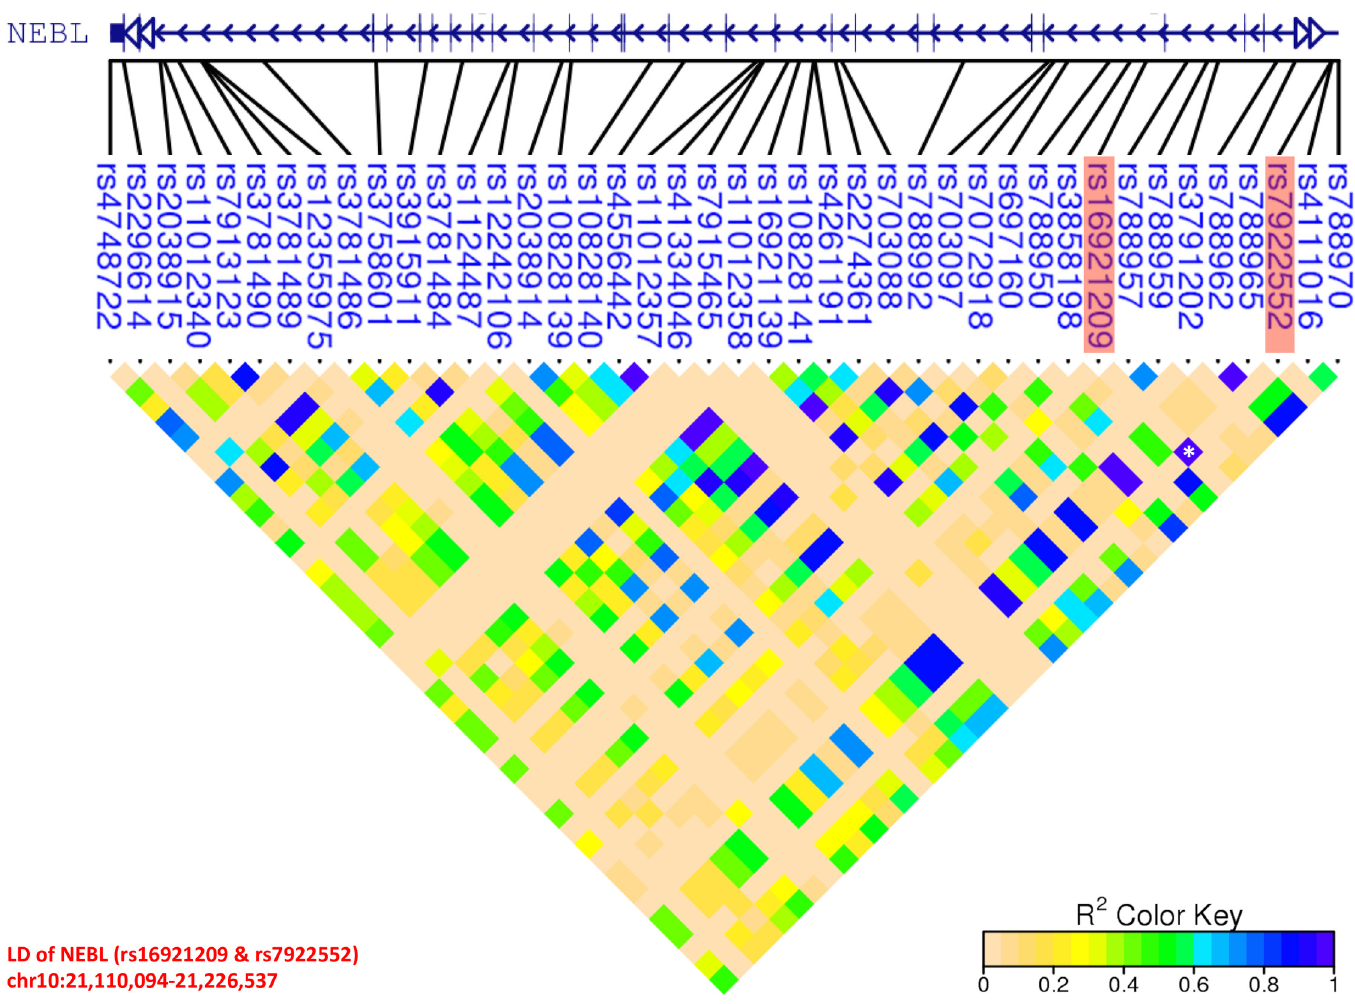
Fig 2. Linkage disequilibrium plot of a region covering all SNPs of NEBL. Two significant SNPs; rs16921209 (P = 7.44 × 10 − 9; OR = 32.22) and rs7922552 (P = 8.43 × 10 − 9; OR = 32.0), both located in the introns of NEBL are in high linkage disequilibrium (r 2 = 0.99), which might imply their co-interplay to susceptibility of CAA formation in KD